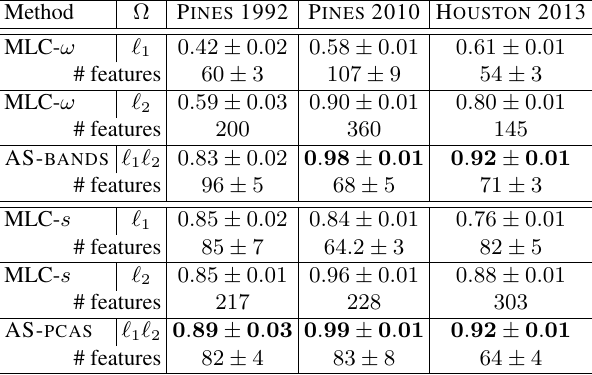
Table 5: Results by MLC classifiers trained with the spectral bands ( ω ), with spatial features extracted from the three first PCAs ( s , including morphological and attribute filters) or with the proposed active set (AS-). In the H OUSTON 2013 case, fea- tures extracted from the DSM have been added to the input